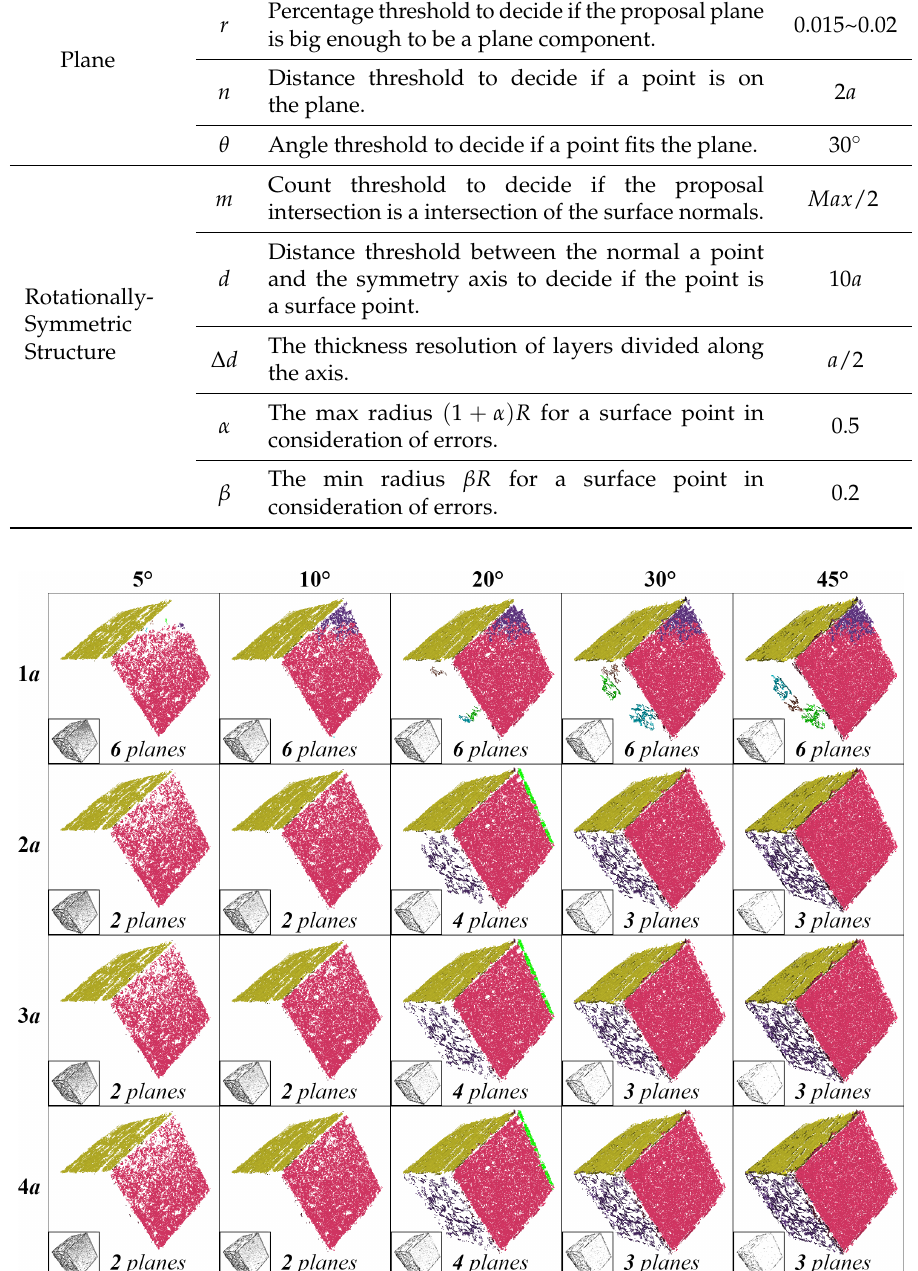
Figure 7. Results of plane detection with different verification thresholds n (rows) and θ (columns). Max np in Algorithm 1 is six. Multiple planes are detected with different colors; point clouds at the lower left corner are the points filtered